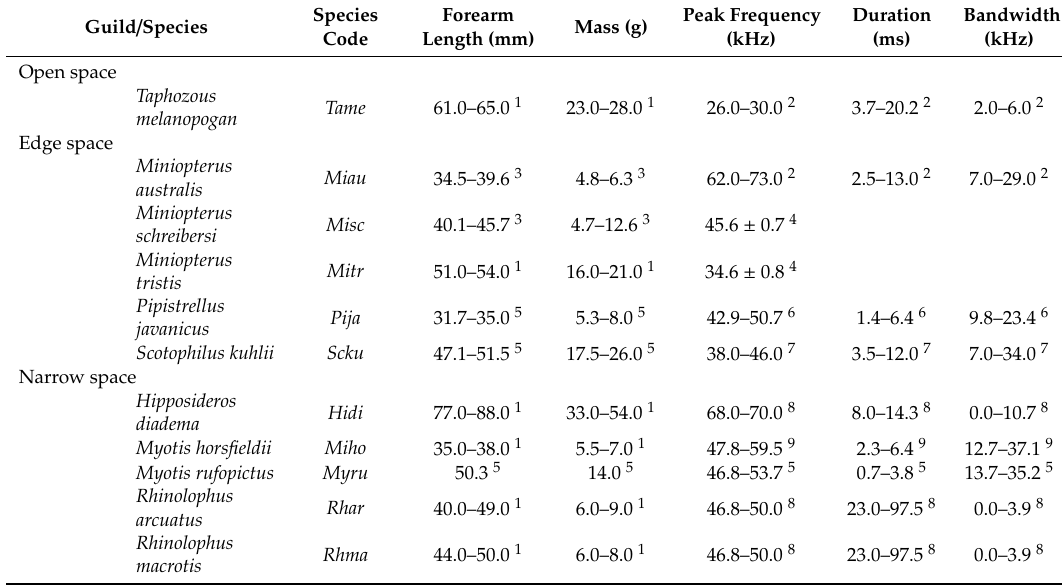
Table 1. Ranges of physical and acoustic measurements characterizing bat species documented within or near the study site and their functional group classification. Sample sizes are all > 10, and represent individuals for the physical traits and call pulses for acoustic